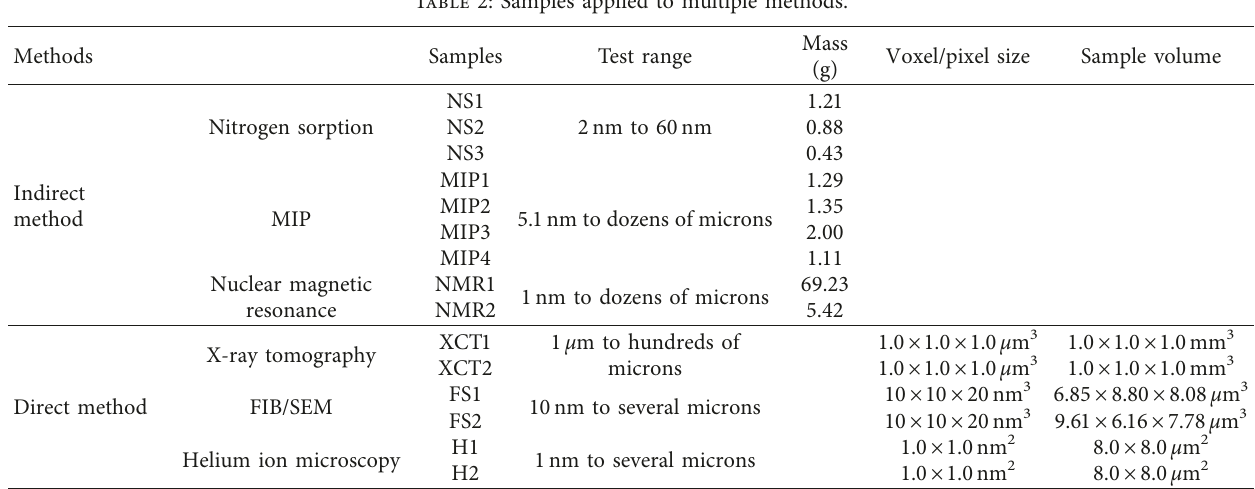
Table 2: Samples applied to multiple